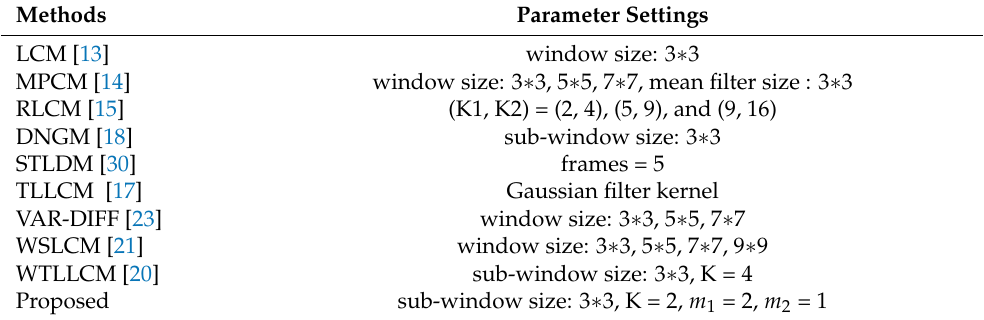
Table 2. The experimental